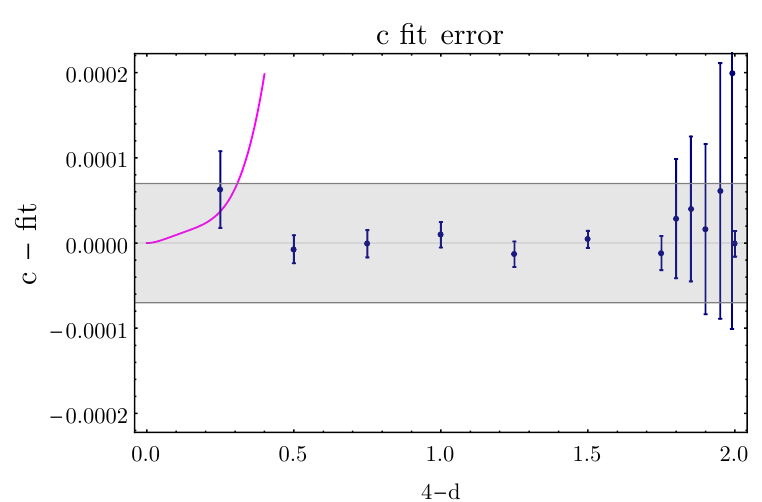
Figure 9 . Fit of central charge c bootstrap data (blue) with overall error (gray) and epsilon expansion (magenta) [31, 32].